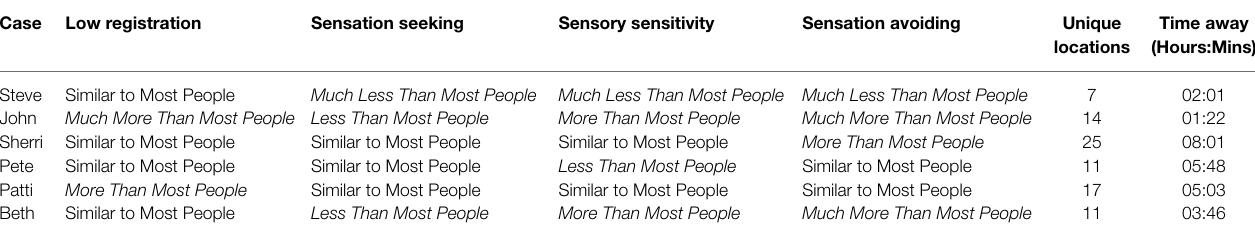
TABLE 2 | Sensory processing patterns and GPS tracking